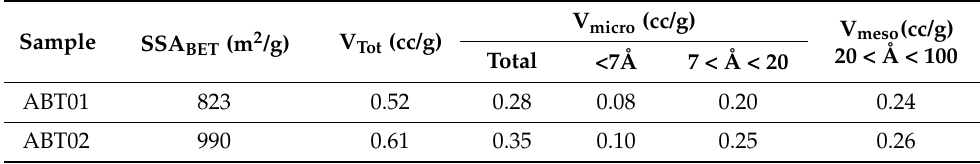
Table 1. Textural properties of ABT materials, assessed via N 2 physisorption analysis performed at 77 K.